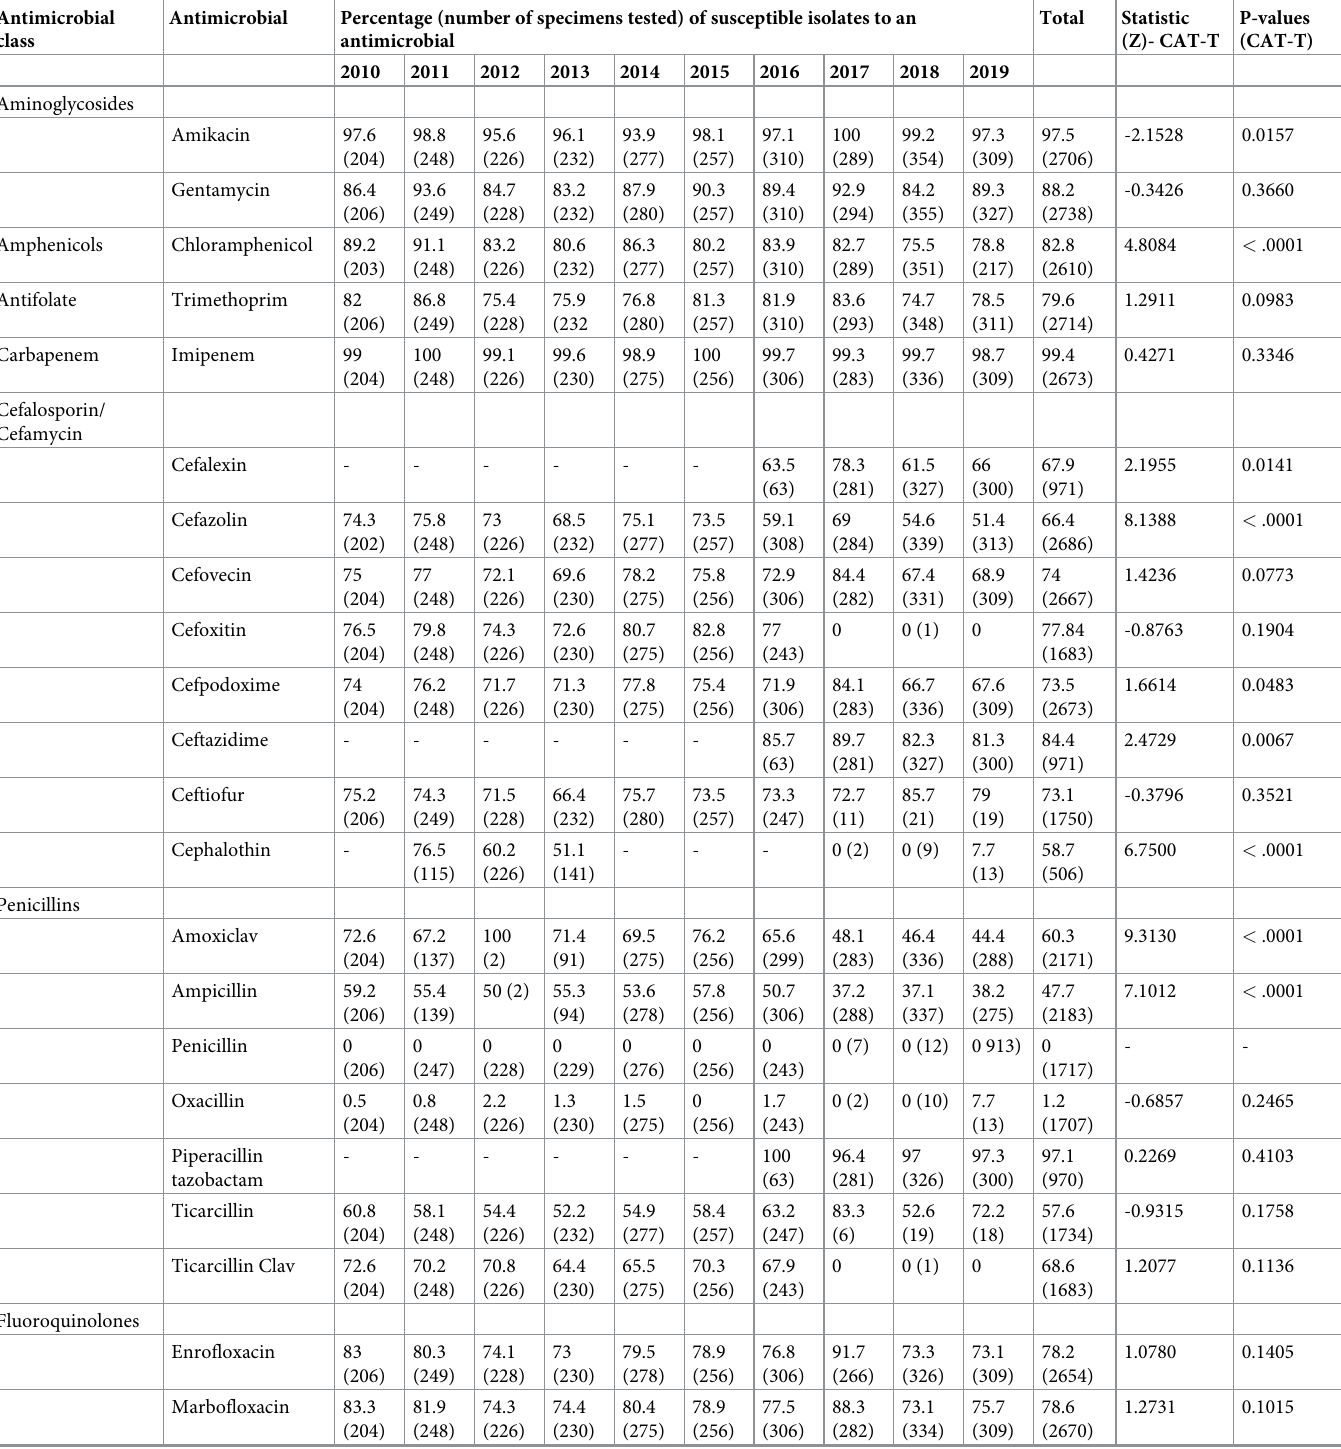
Table 2. Trends in antimicrobial susceptibility of Escherichia coli isolated from dog specimens tested at the Indiana Animal Disease Diagnostic Laboratory, 2010– 2019. Antimicrobial